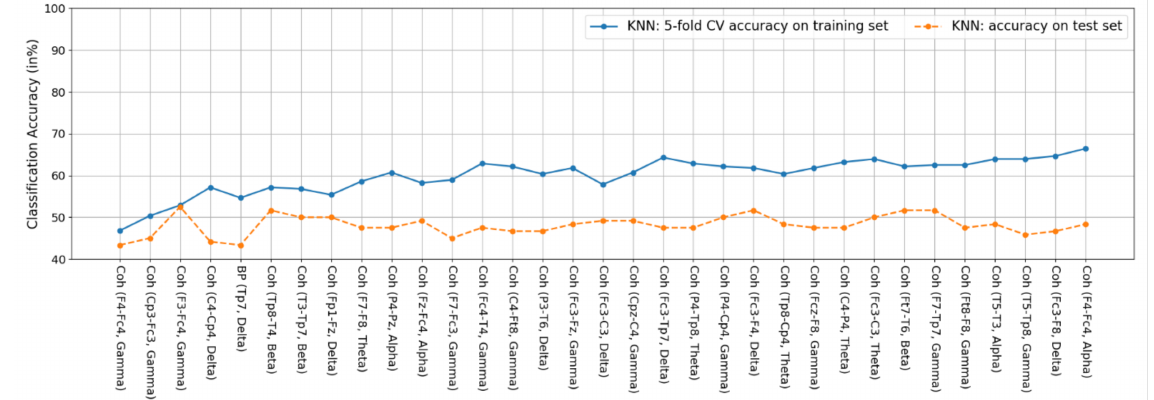
Figure A1. Features of the K -NN classifier. Among the 33 features, 32 are coherence features and the remaining one feature is the delta BP feature at